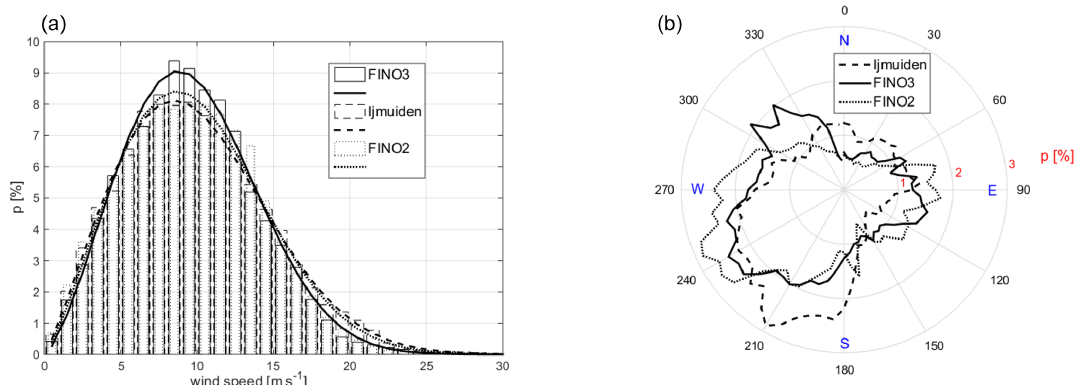
Figure 3. Wind speed (a) and wind direction (b) distributions for the three 24-month datasets from the FINO3, IJmuiden and FINO2 offshore met mast sites. Derived statistics are summarised in Table 1.